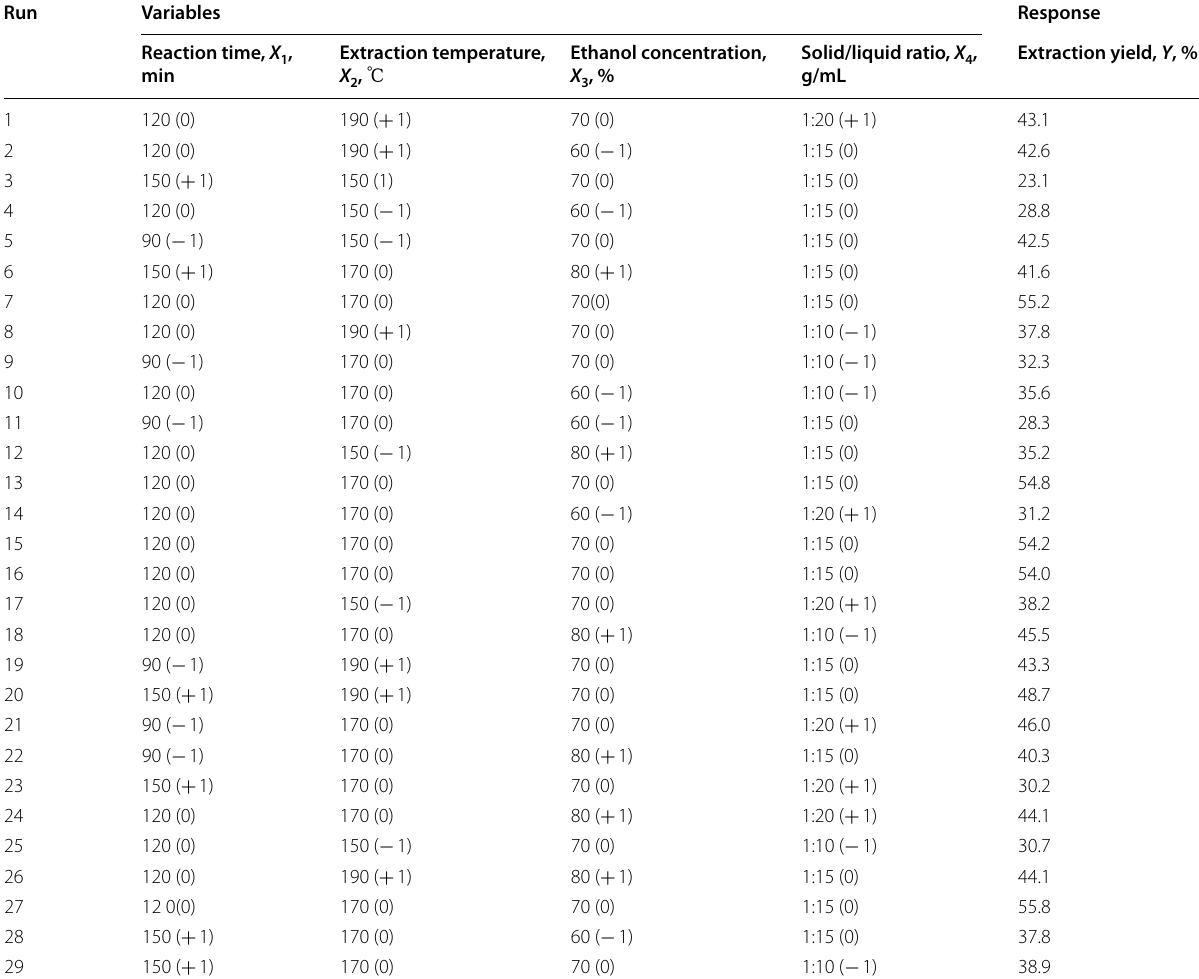
Table 2 Experimental results of the RSM